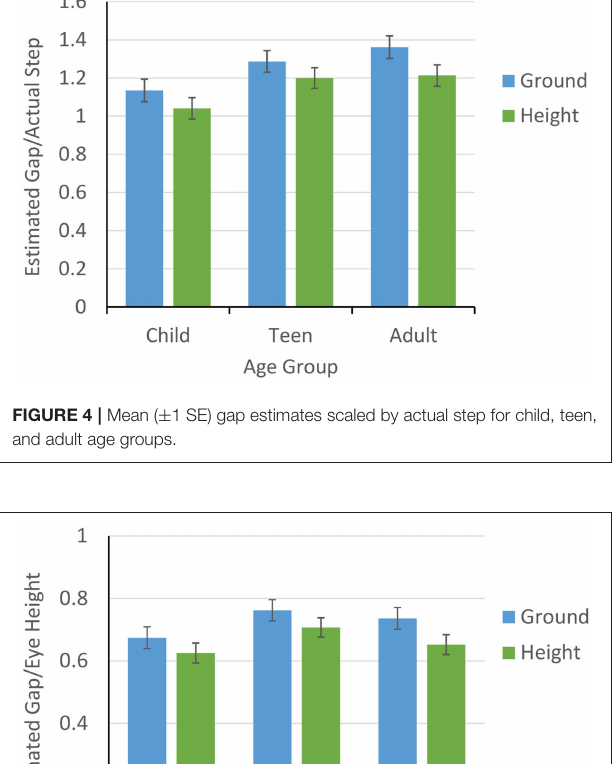
with height, suggesting that increases in perceived risk affected the gap-crossing estimates of all age groups